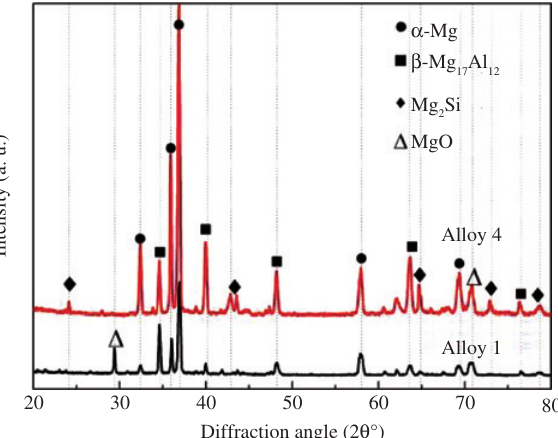
Figure 2: XRD patterns of the base Mg alloy (alloy 1) and FAC/Mg alloy degradable composites (alloy